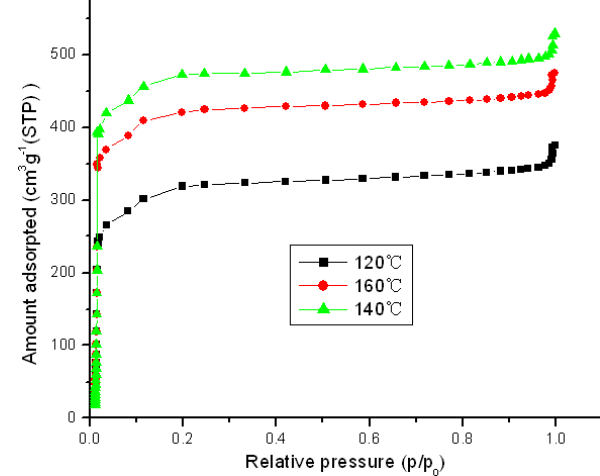
Figure 5: Effect of reaction temperature on the stability of the crystal MOF-5.